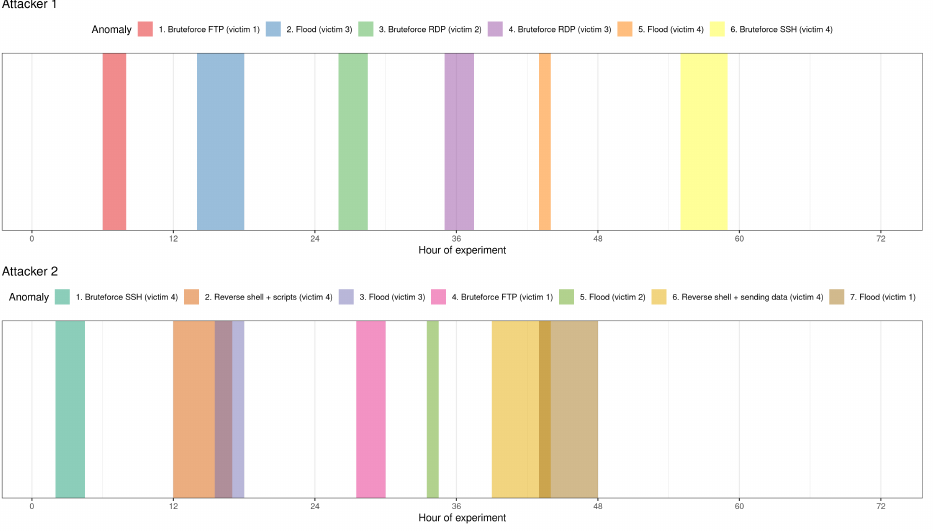
Figure 3. Graphic presentation of the moments of the attacks and their durations (for each attacker